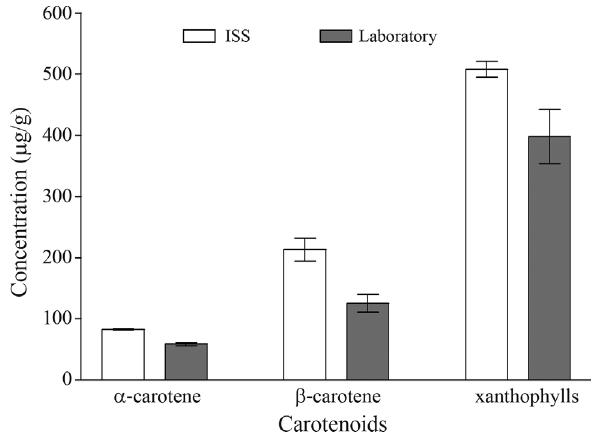
Figure 3 - Synthesis of carotenoids in 30-day plantlets derived from seeds germinated in microgravity (ISS) and terrestrially (Laboratory). The caro- tenoid content was measured relative to leaflet fresh weight, and pairs of measurements between the ISS and the terrestrial laboratory are signifi- cant at p < 0.05 for (cid:4) carotene and p < 0.01 for xanthophylls, but were not